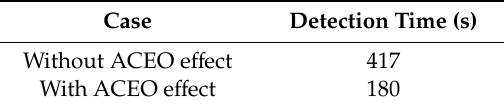
Response time for C-reactive protein (CRP) binding reaction. current